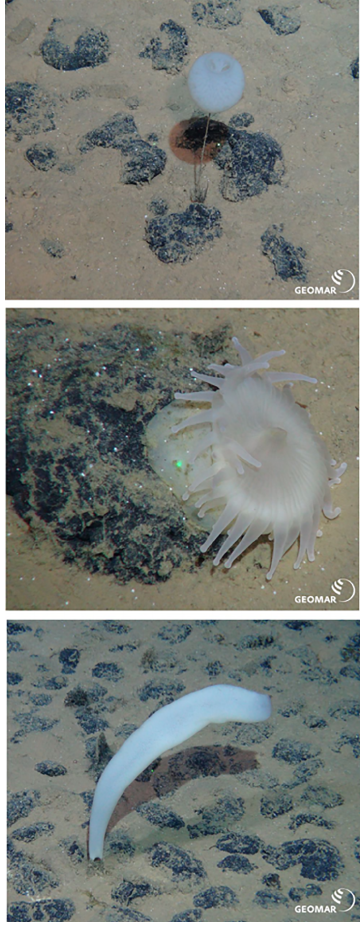
Figure 1. Sessile benthic organisms depending on manganese nod- ules as a hard substrate habitat. Images are from the German claim area in the Clarion–Clipperton Zone (photos: remotely operated ve- hicle (ROV) Kiel 6000, GEOMAR Helmholtz Centre for Ocean Re- search Kiel,